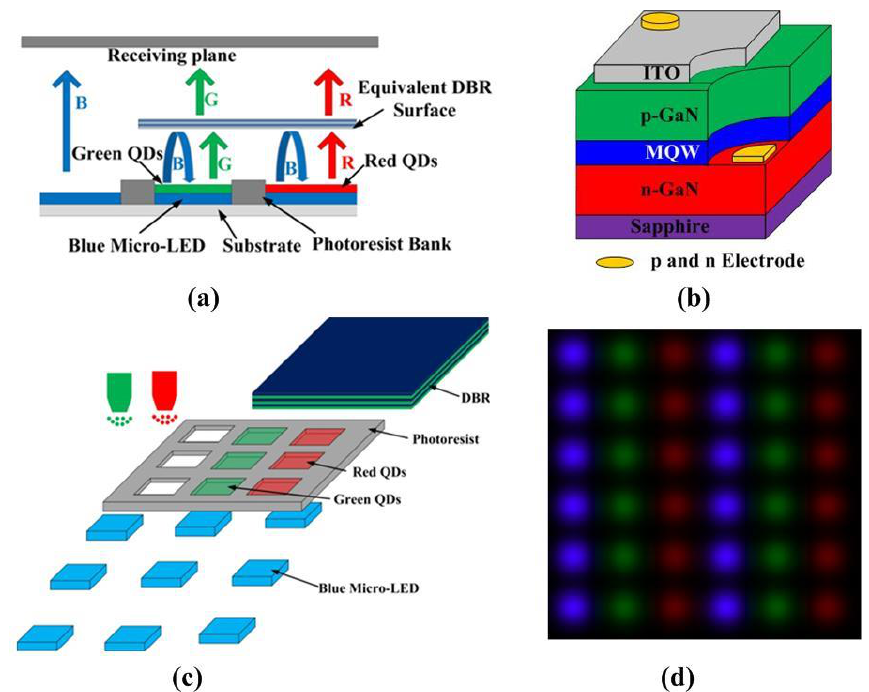
Figure 5. Schematic configuration of GaN-based micro-LEDs with a QDs matrix ( a ) 2-dimensional view; ( b ) the structure of blue micro-LED chip [5]; ( c ) 3-dimensional view; and ( d ) illumination distribution on the receiving plane for the red/green/blue pixel.